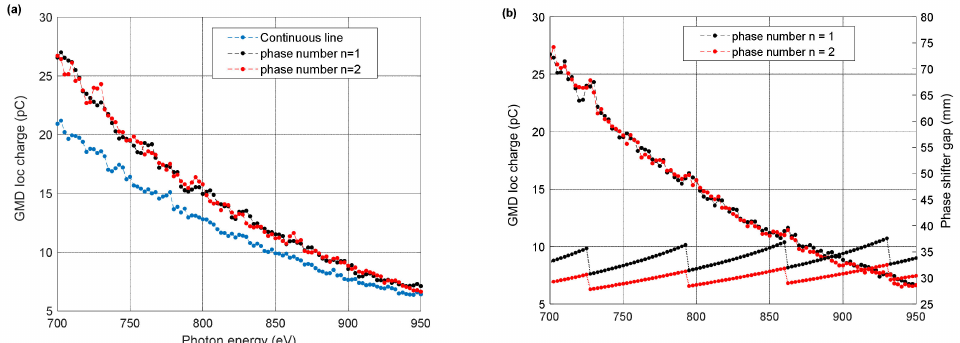
Figure 12. ( a ) The FEL intensity measured with a GMD as a function of photon energy for the three cases of photon energy scan. ( b ) the phase-shifter gap as a function of photon energy for the case of n = 1 and n = 2. The continuous line is the same as in Figure